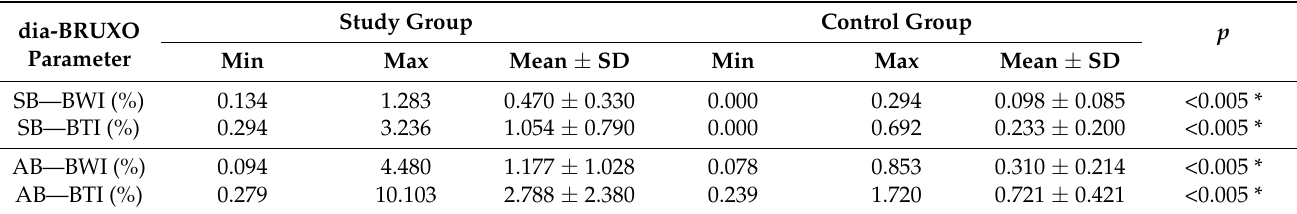
Table 4. BWI and BTI indexes in SB and